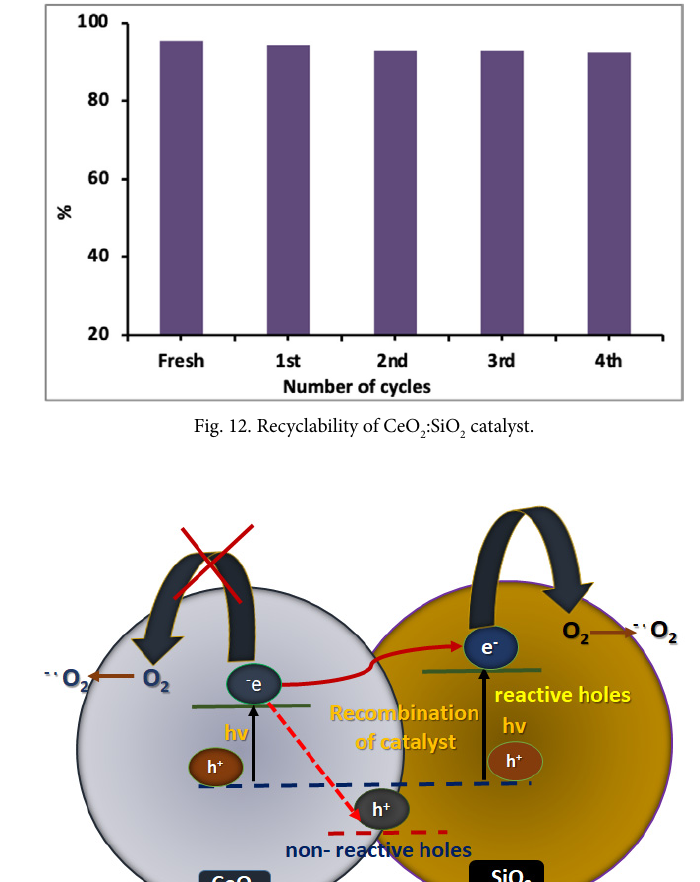
:SiO photocatalyst. 2 2